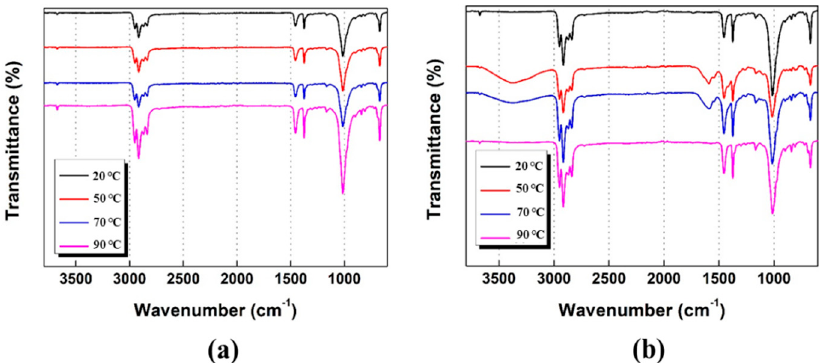
Figure 6. FTIR spectra of polypropylene/lubricant composites aged at different temperatures at a 100% humidity: ( a ) PP/Mg; ( b ) PP/Ca.